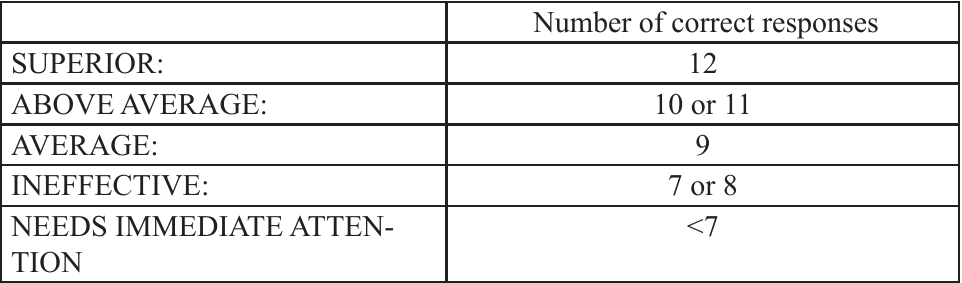
Number of correct